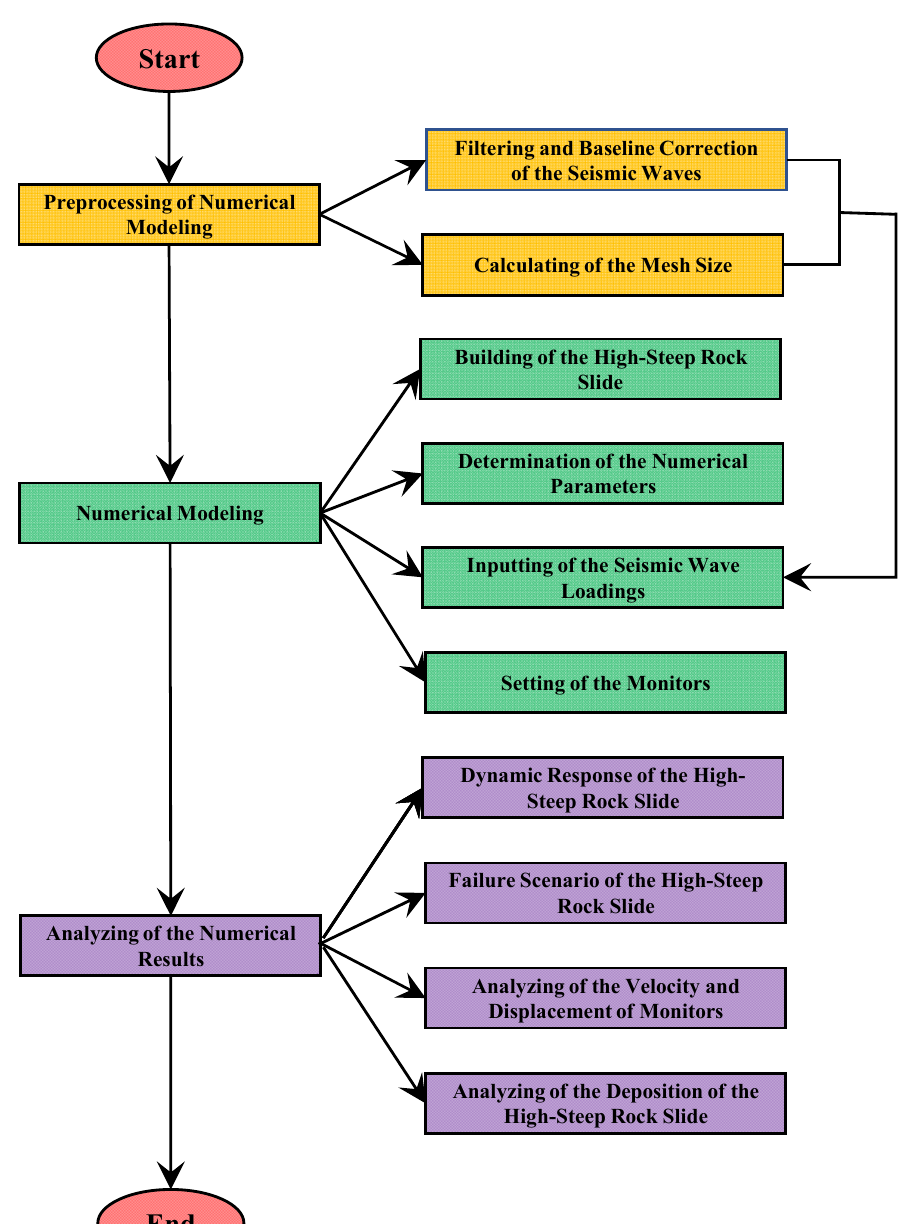
Figure 5. The flowchart of numerical investigation on the effects of the dynamic response and failure behavior of the high ‐ steep rock slide.